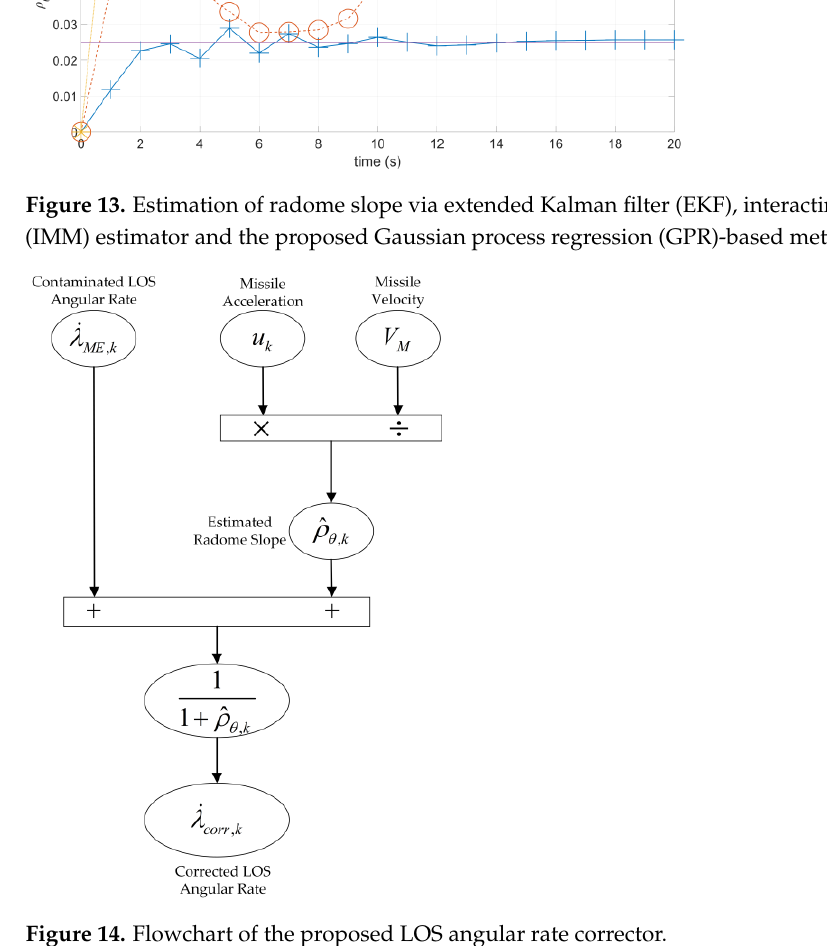
Figure 15. Deviation between the contaminated LOS angular rate ME  and the true LOS angular rate  with different values of the radome slope   . Figure 16. Estimation error of the radome slope   in different cases.